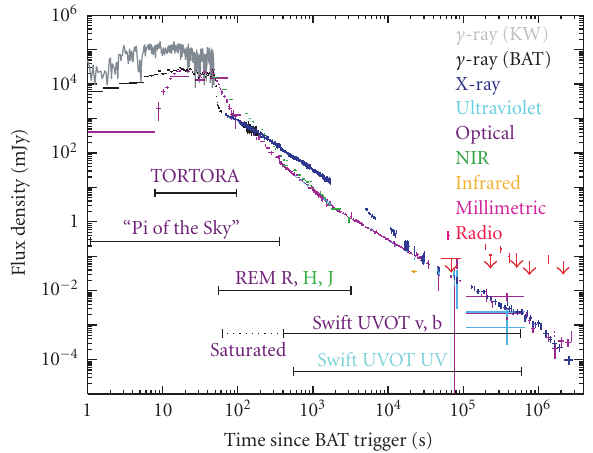
Figure 6: Light curves of GRB 080319B, including radio, mili- metric, infrared, NIR, optical, ultraviolet, X-ray, and gamma ray flux densites. The original light curve was taken from Racusin et al. [18]. Bars with names of di ff erent instruments show timescales of di ff erent observations.